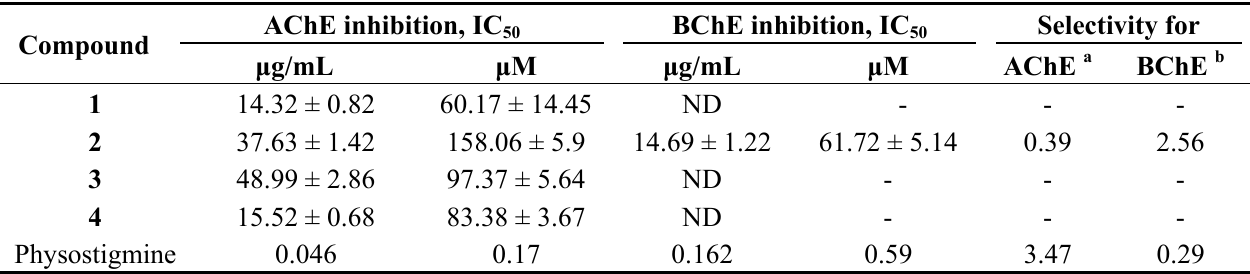
values of Rauvolfia reflexa chemical constituents for inhibitory activities on Table 2. IC 50 cholinesterase